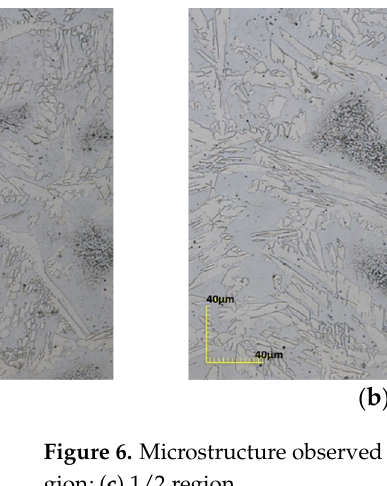
( c ) Figure 7. Microstructure observed in the HAZ of the as welded condition sample: ( a ) edge; ( b ) 1/4 region; ( c ) 1/2 region. No intermetallic precipitates were identified in the microstructure other than chro- mium nitride (Cr 2 N).